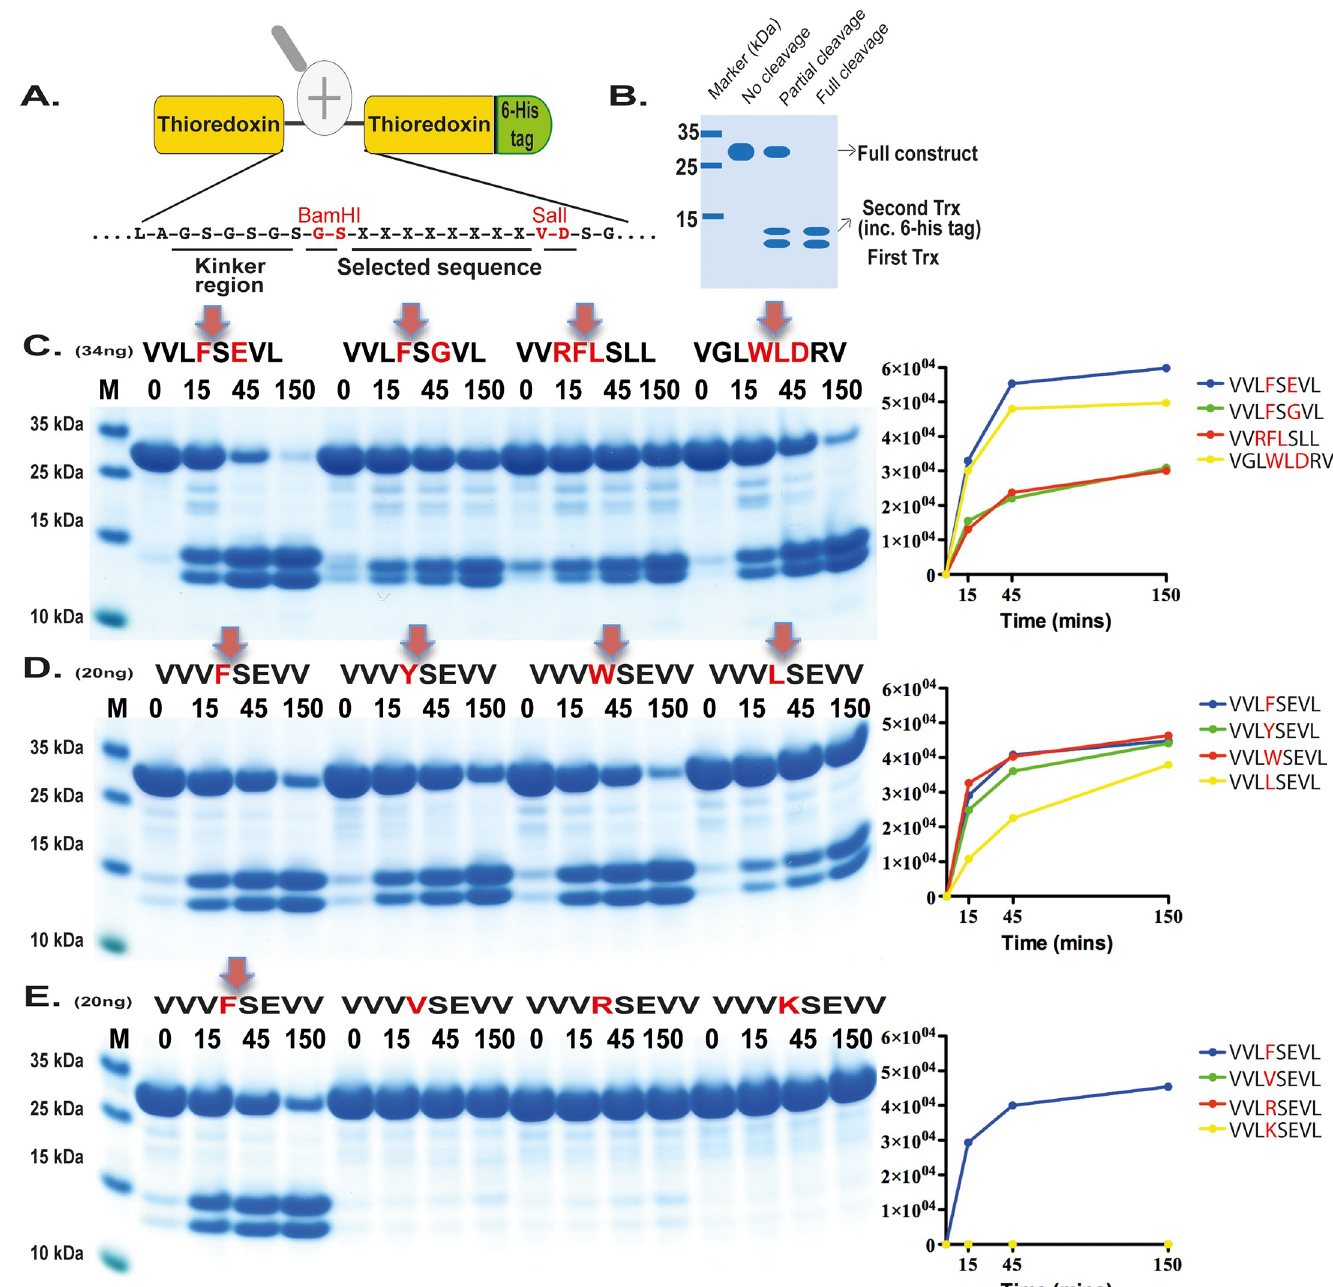
Fig 8. Analysis of the cleavage specificity of HAM1 by the use of recombinant protein substrates. Panel A shows the overall structure of the recombinant protein substrates used for analysis of the efficiency in cleavage by HAM1. In these substrates two thioredoxin molecules are positioned in tandem and the proteins have a His 6 -tag positioned in their C termini. The different cleavable sequences are inserted in the linker region between the two thioredoxin molecules by the use of two unique restriction sites, one Bam HI and one SalI site, which are indicated in the bottom of panel A. In panel B an example cleavage is shown to highlight possible cleavage patterns. Panels C, D and E shows the cleavage of a number of substrates by HAM1. The sequence of the different substrates are indicated above the pictures of the gels. The time of cleavage in minutes is also indicated above the corresponding lanes of the different gels. The uncleaved substrates have a molecular weight of approximately 25 kDa and the cleaved substrates appear as two closely located bands with a size of 12–13 kDa.